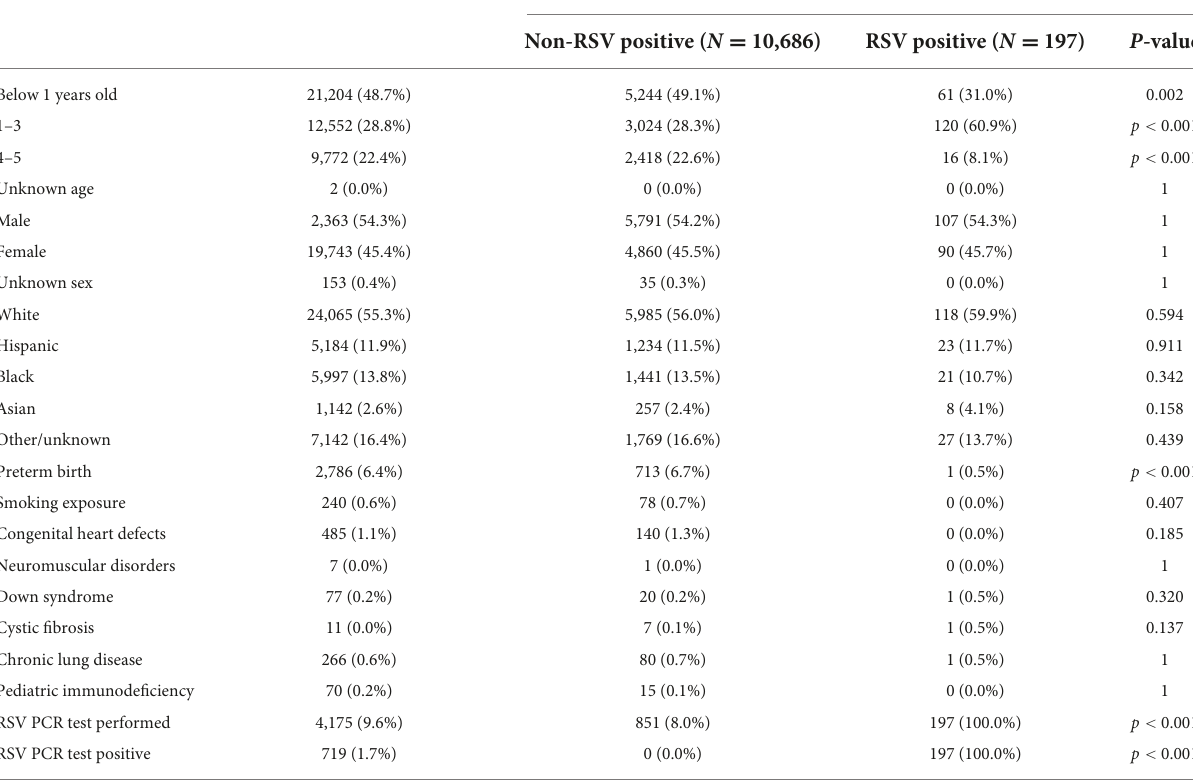
TABLE 1 Demographic data of non-RSV positive and RSV positive patients with hospital encounters included in the holdout test